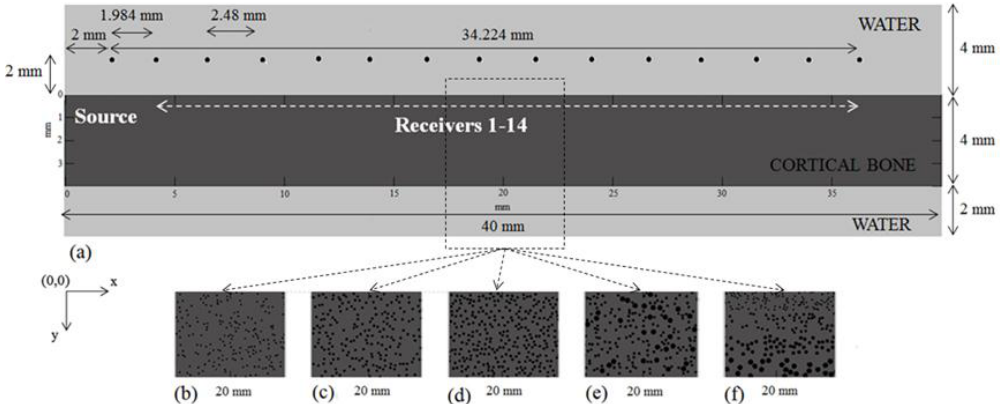
Figure 1. Numerical models of cortical bone corresponding to the first set of simulations (Series I_Po0-16) and Table 2, namely: ( a ) B_Hom; ( b ) B_Po5; ( c ) B_Po10; ( d ) B_Po16; ( e ) B_Po16_RL; and ( f ) B_Po16_Gradual. For each geometry, only one of the three random porosity distributions is depicted in the form of 5 mm cortical segments derived from the original 40mm ˆ 4mm plates. The ultrasound configuration is also presented in ( a ). Table 1. Elastic coefficients and density used for the simulations